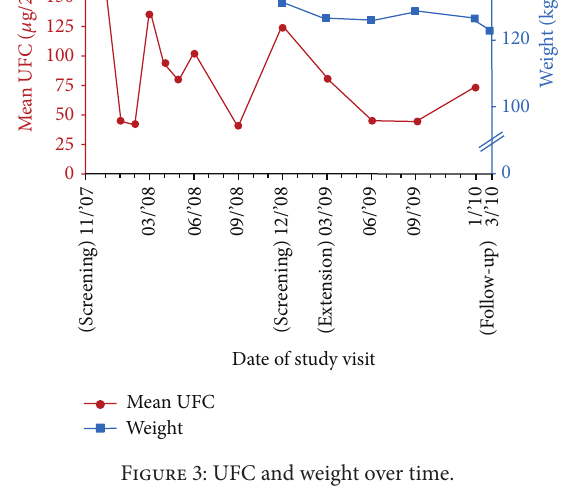
Figure 3: UFC and weight over time.